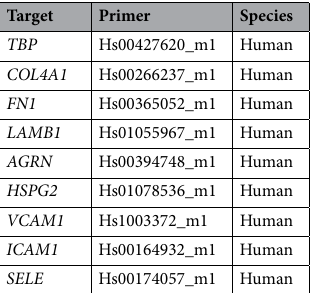
Table 1. Gene expression assays used in expression studies. Gene-specific TaqMan Gene Expression Assays were obtained from Applied Biosystems (Carlsbad,